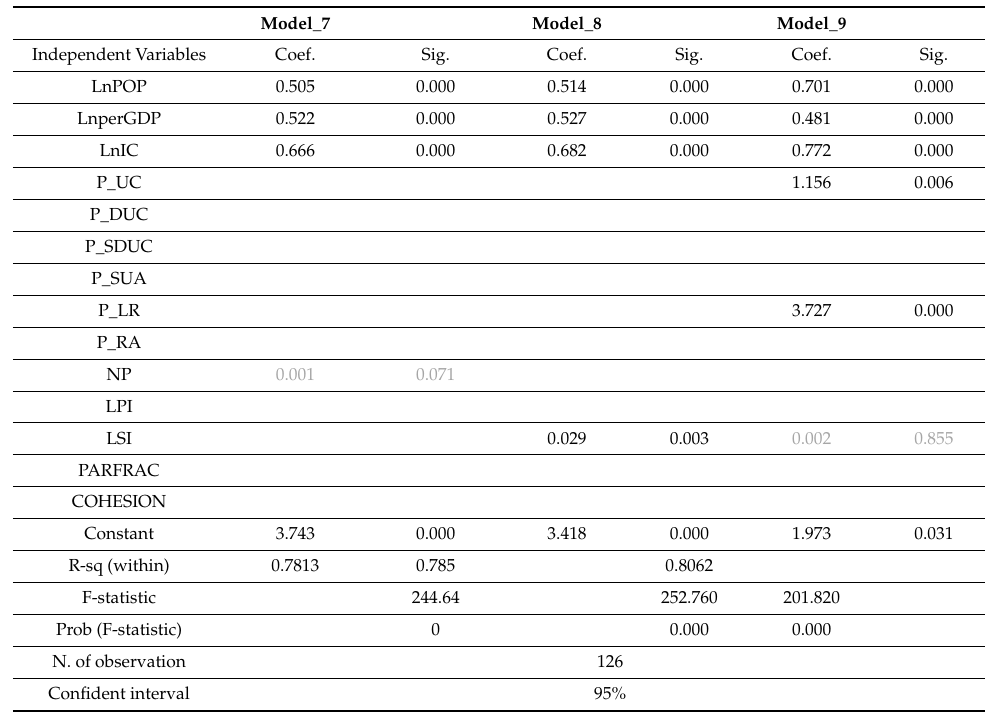
Table 6. Model results of GHG emissions and landscape pattern indicators. Model_7 Model_8 Model_9 Independent Variables Coef. Sig. Coef. Sig. Coef.